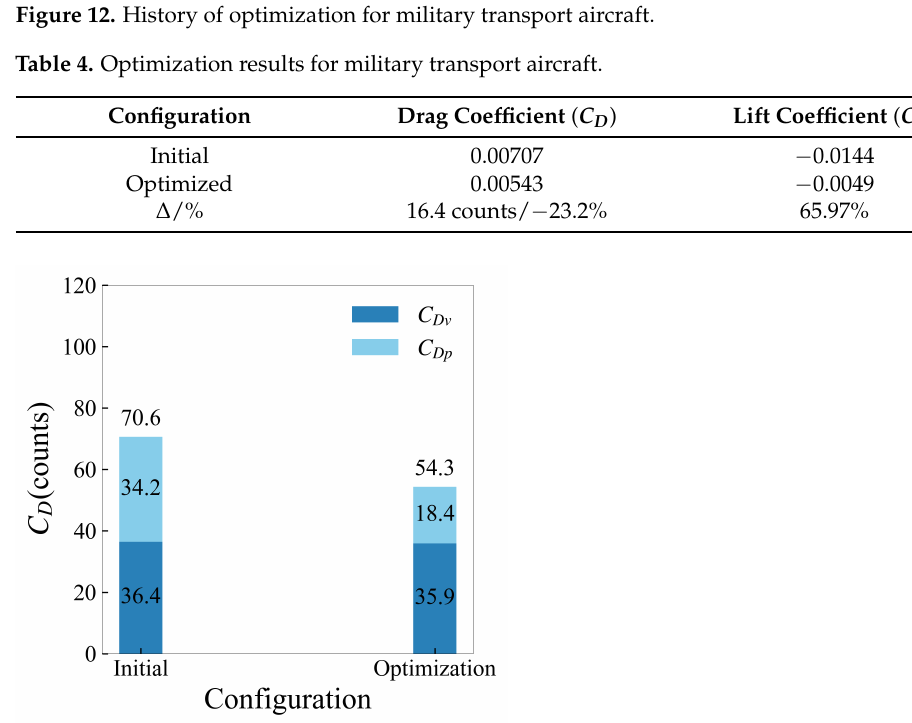
Figure 13. The decomposition of drag for military transport